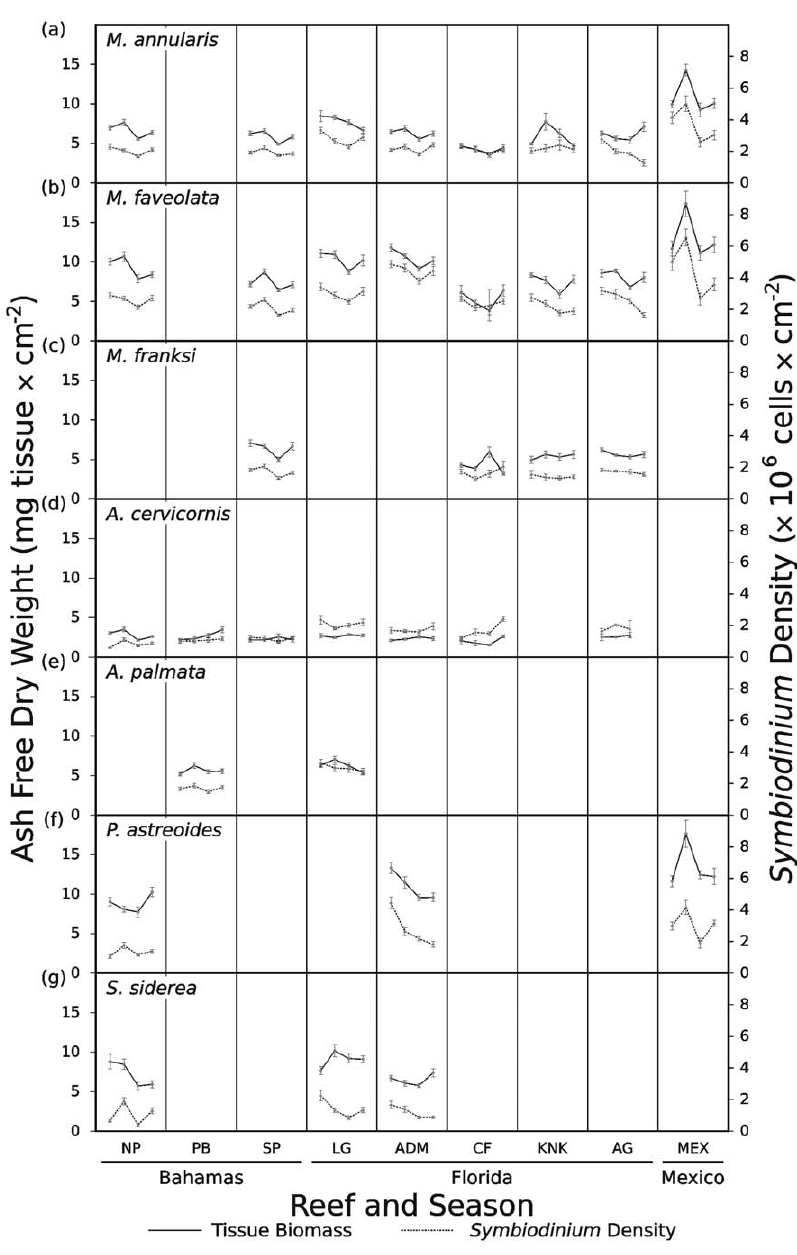
Figure 5. Seasonal variation in coral biomass and Symbiodinium density for seven coral species from nine reefs. Coral tissue biomass (left axis and solid lines) and Symbiodinium density (right axis and dashed lines) data presented as mean values for a given season 6 standard error. Within each line plot, four sample dates are provided, one each for winter (January to March), spring (April to June), summer (July to September) and fall (October to December). Seasonal means are presented chronologically beginning with winter and ending with fall. A blank sub-panel indicates that a particular coral species did not occur at that specific location. Reef abbreviations provided in Fig. 1. Statistical analyses of these data are given in Table